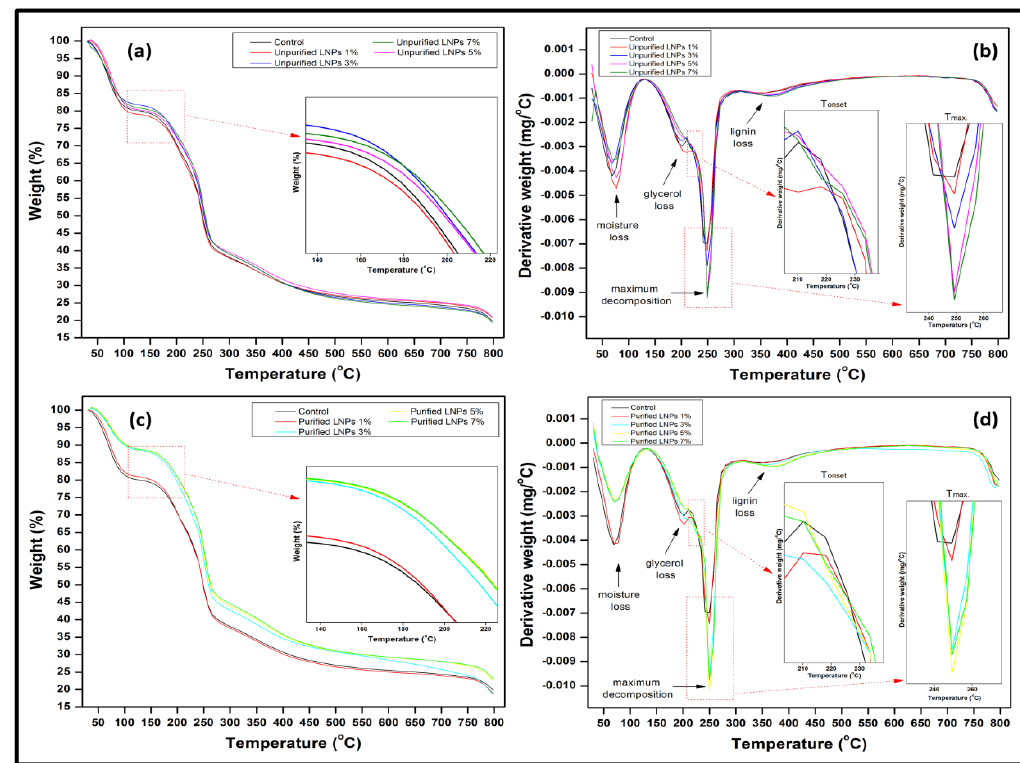
Figure 9. Thermogravimetric analysis of unpurified LNPs based films ( a ) TGA and ( b ) DTG, and purified LNPs based films ( c ) TGA and ( d ) DTG as a function of temperature for the LNPs/macroalgae biopolymer films. Table 1. Decomposition temperatures and mass loss data of macroalgae film with different loading of unpurified LNPs and purified LNPs.